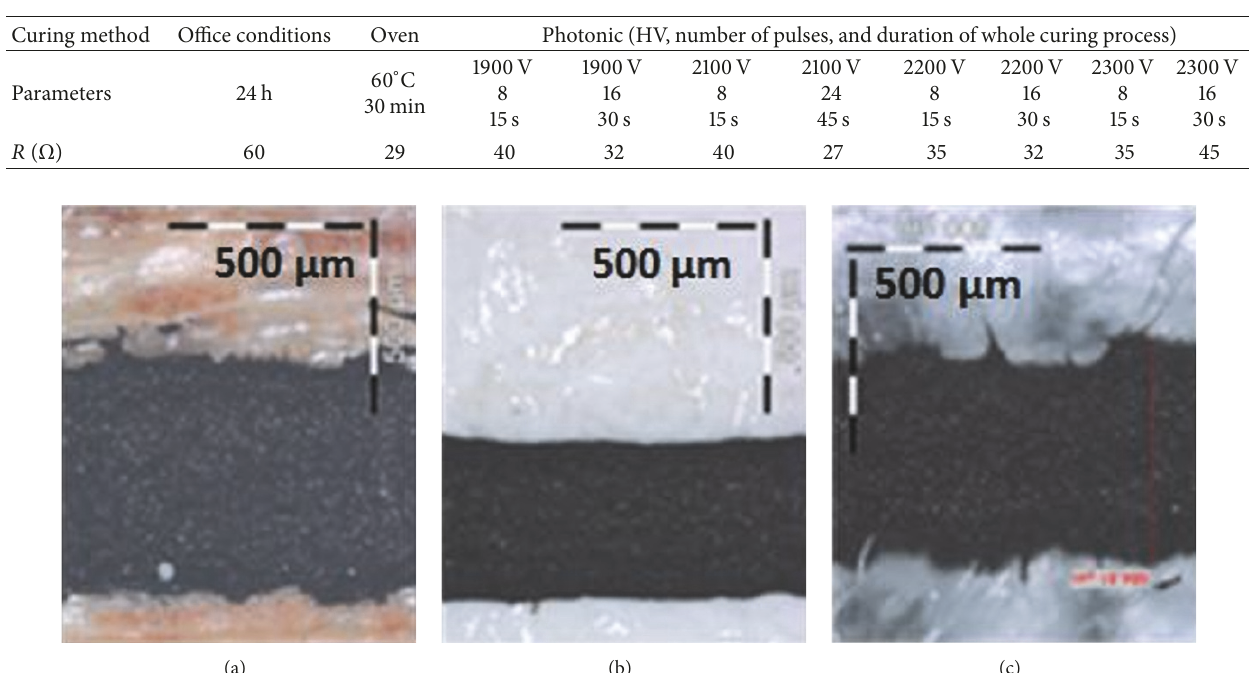
Figure 3: Optical microscopic image of a single, one-layer graphene line deposited by 3D microdispenser on (a) wood, (b) cardboard, and (c) textile (magnification × 5).